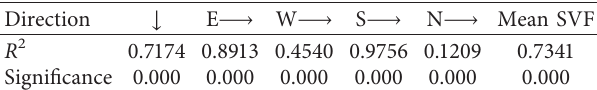
Figure 14: Linear fitting between seven-day mean T directional SVF as well as the mean SVF. Table 4: Summary of R 2 in linear fitting between seven-day mean T mrt and the directional SVF i as well as the mean